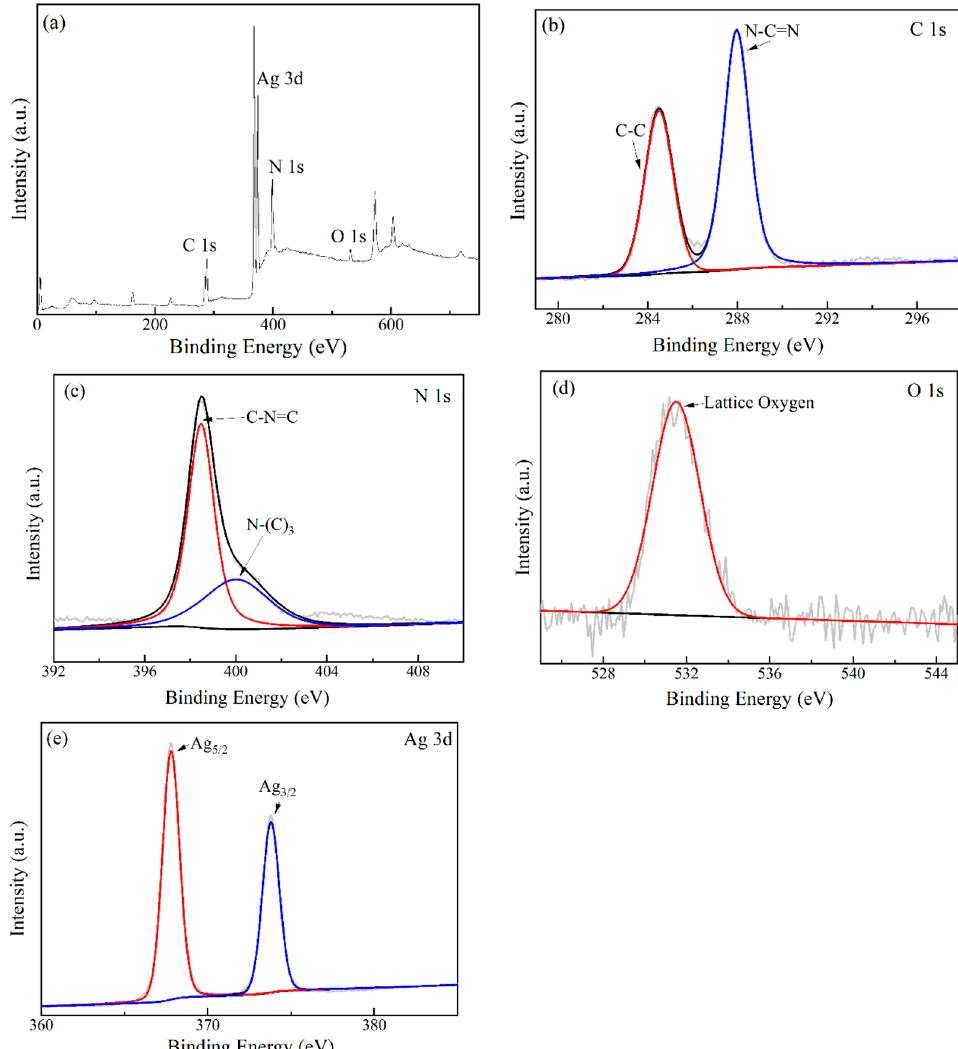
Figure 4. XPS spectrograms of ( a ) all elements, ( b ) C 1s, ( c ) N 1s, ( d ) O 1s, and ( e ) Ag 3d in Ag 2 O/g-C 3 N 4.